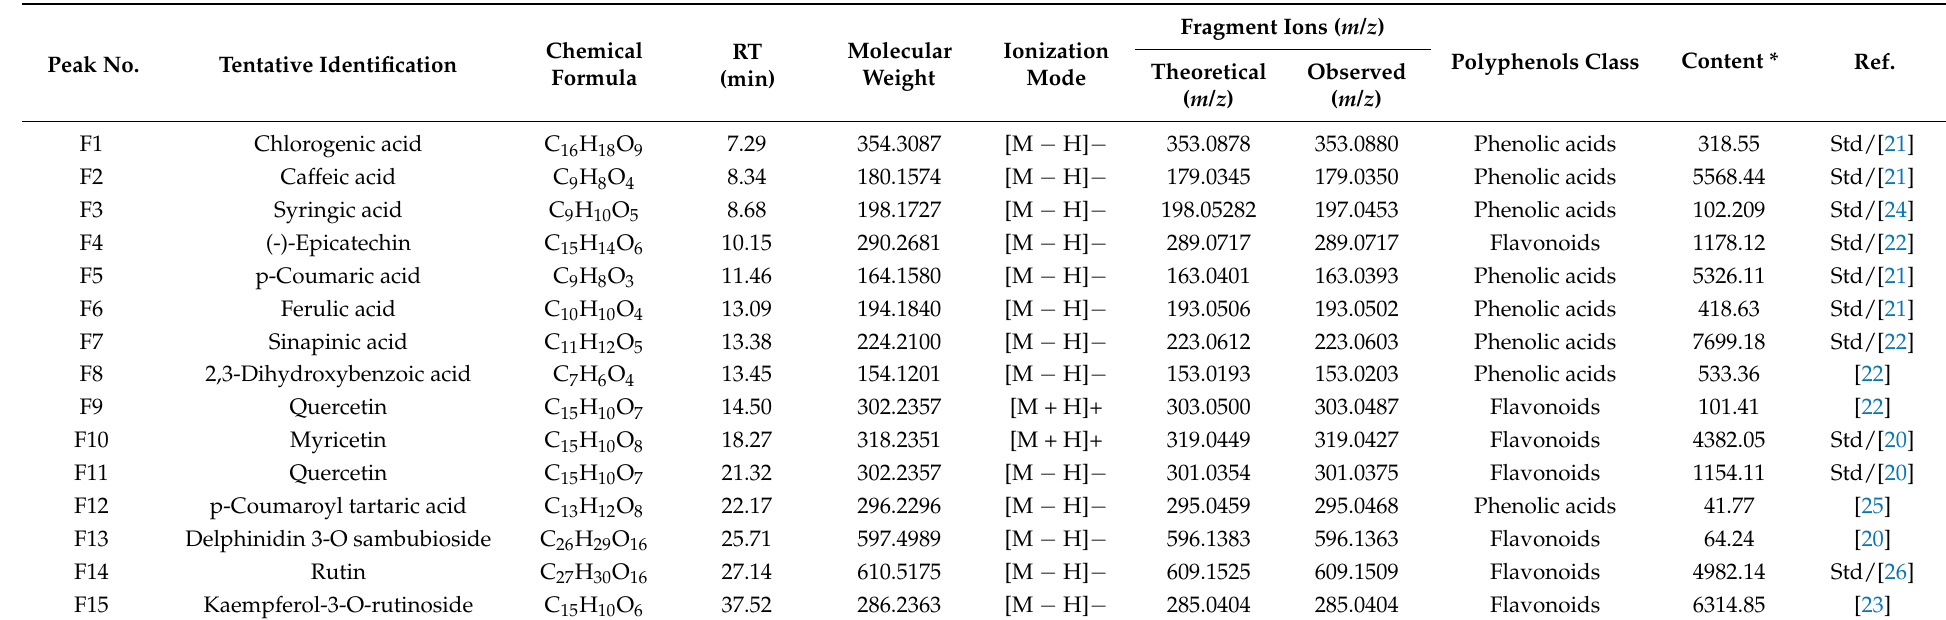
Table 2. Identification and quantification of the different compounds present in A. vulneraria flower extract using HPLC-MS.